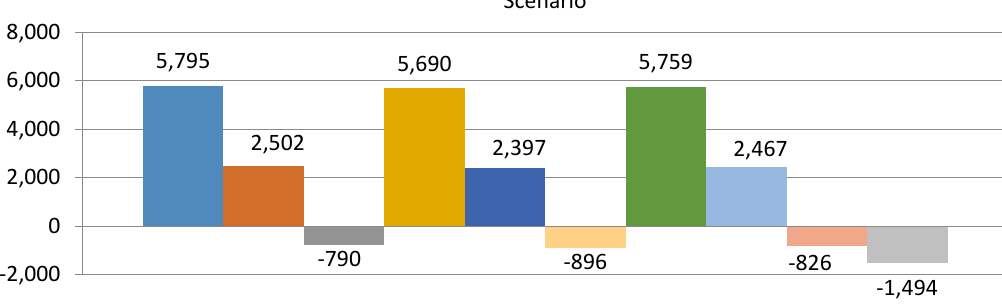
Figure Figure 8 NPV for each scenario if the forecasting period equals five years, there are 1000 micro-